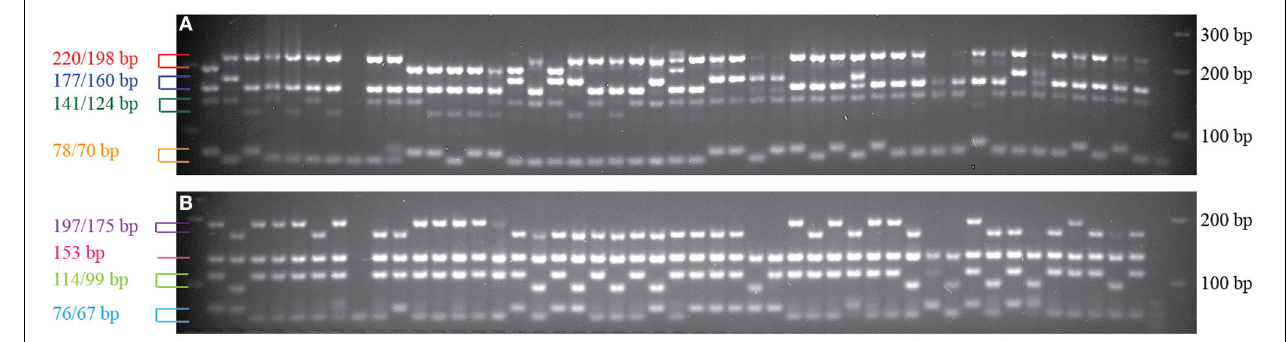
FIGURE 6 | Multiplexing of markers on 48 Middle American bean genotypes showed distinct bands on the 3% agarose gel electrophoresis. (A) Amplification products using InDel markers NDSU_IND_05_37.2272, NDSU_IND_06_16.5002, NDSU_IND_11_30.9655, and NDSU_IND_06_31.8021 on 48 bean genotypes. All four markers showed